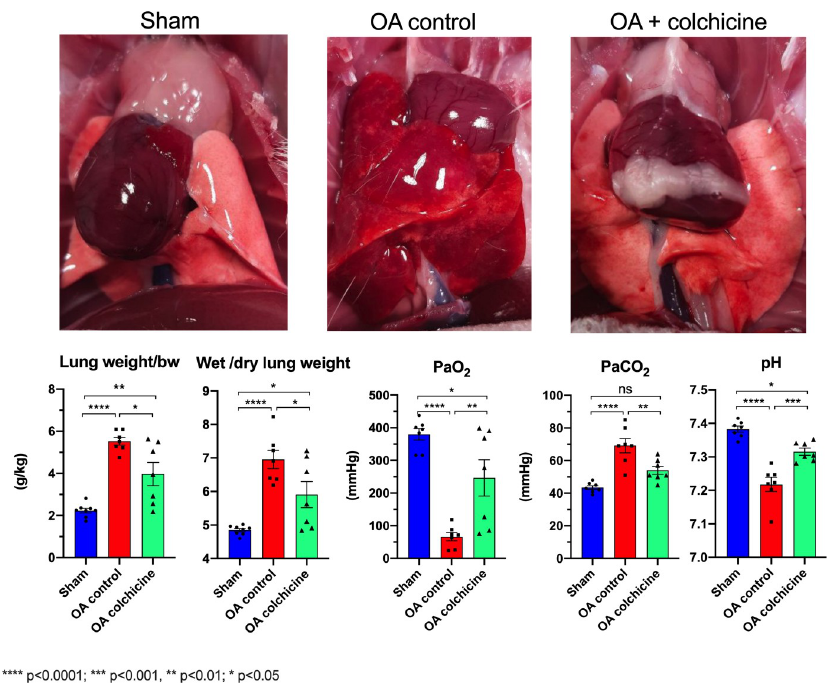
Fig 1. Effects of colchicine therapy on oleic acid-induced ALI, lung edema and gas exchange. Values are mean ± SEM. ���� p < 0.0001; ��� p < 0.001, �� p < 0.01; � p < 0.05.